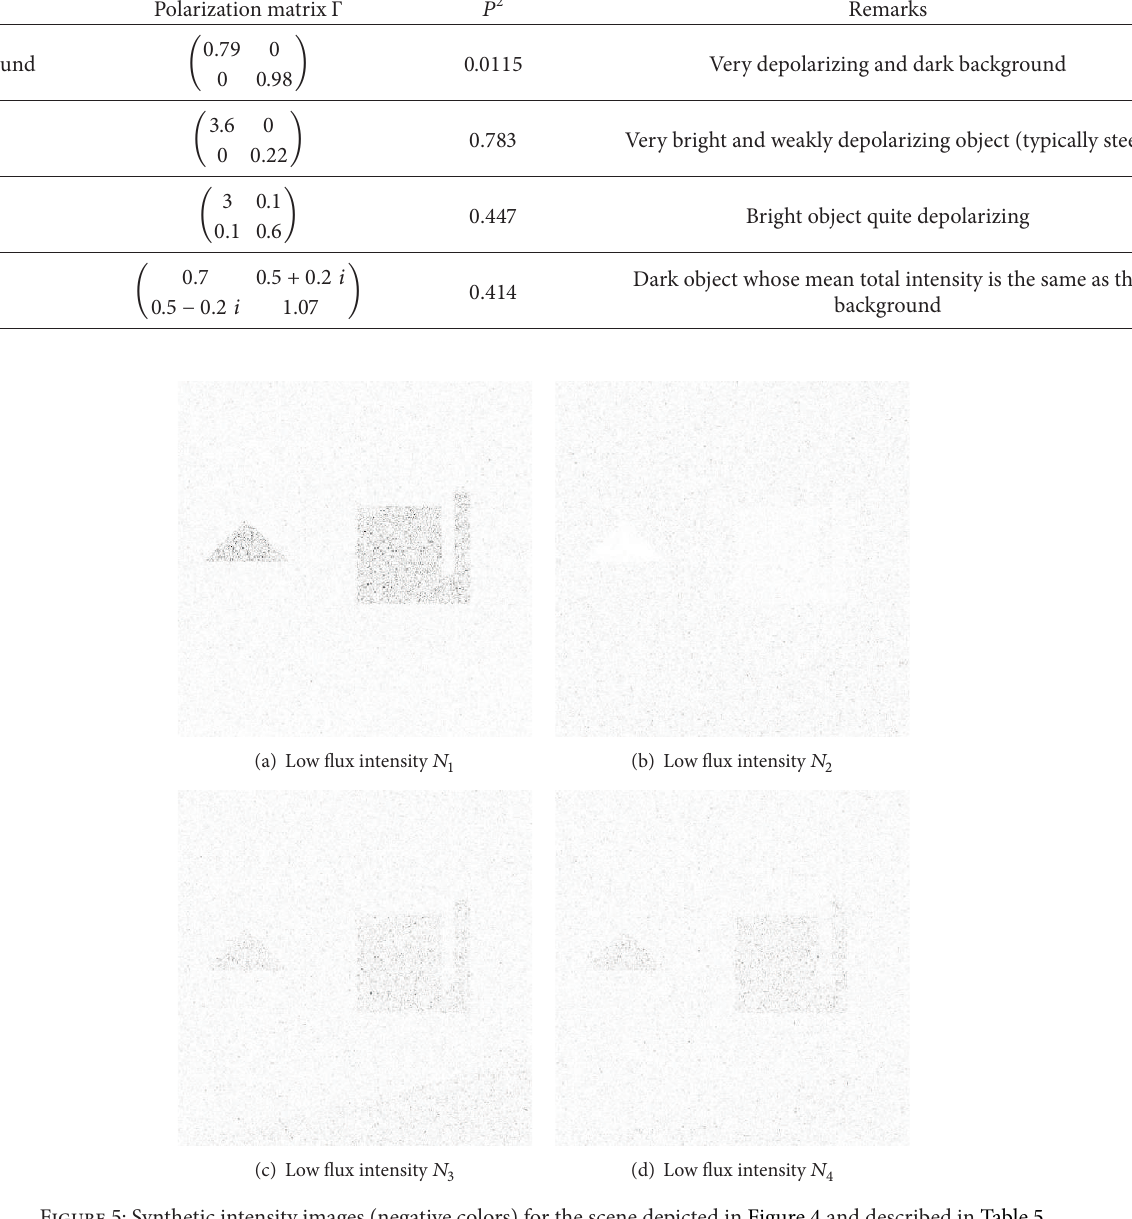
Figure 5: Synthetic intensity images (negative colors) for the scene depicted in Figure 4 and described in Table 5.